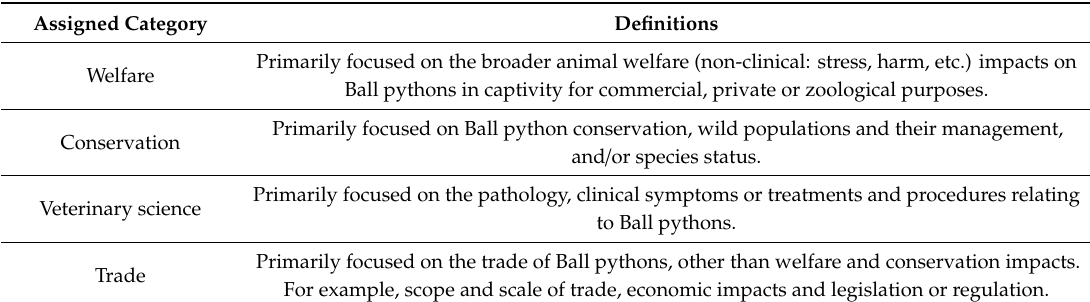
Table S1—Definition of terms (behaviour); Table S2—Definition of terms (health); Table S3—Definition of terms (bacteria); Table S4—Definition of terms (parasite); Table S5—Definition of terms (virus); Table S6—Definition of terms